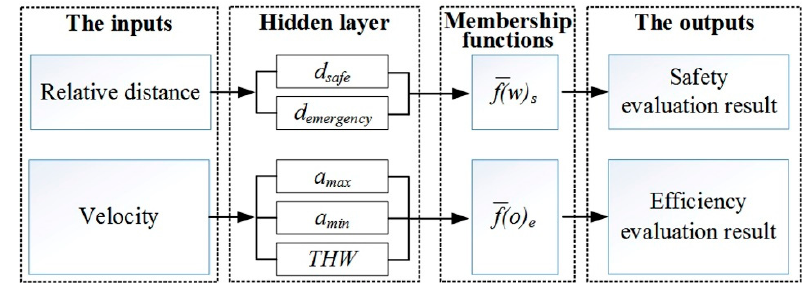
Figure 9. The architecture scheme of fuzzy classification Algorithm.